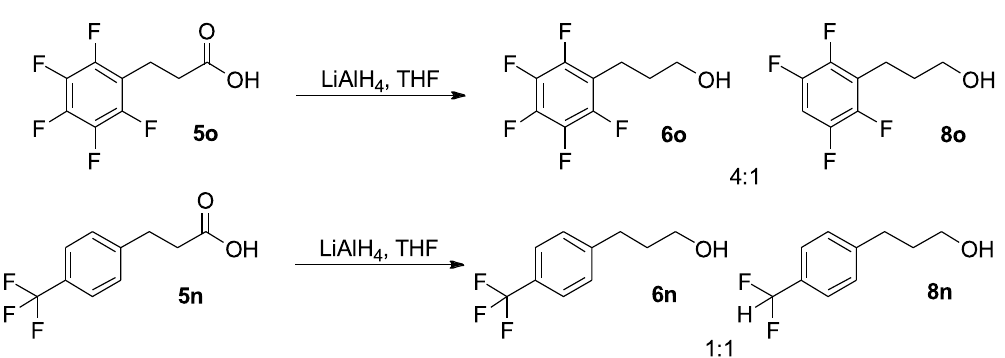
Figure 5. Reduction of carboxylic acids to afford hydrocinnamyl alcohol.